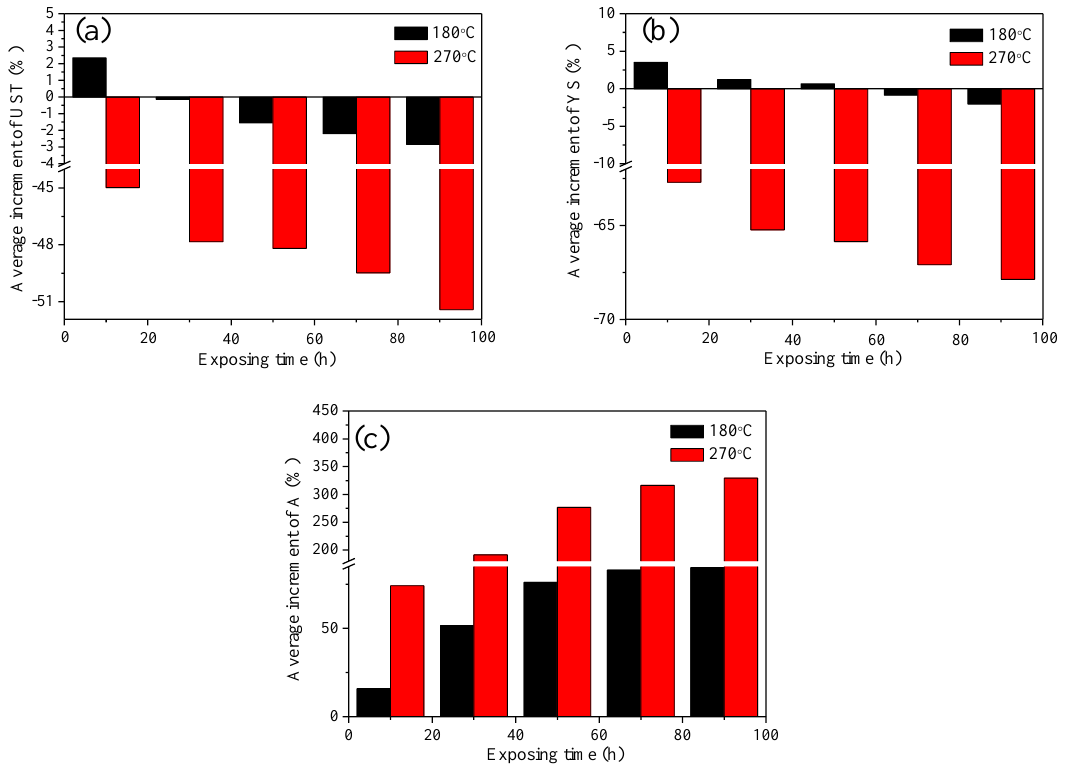
Figure 3. Average increment of tensile properties of the studied alloy as a function of the exposure time. ( a ) UST, ( b ) YS and ( c ) A.